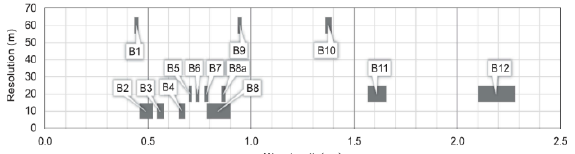
Figure 2. Sentinel-2 bands (Richter & Schläpfer, 2013)